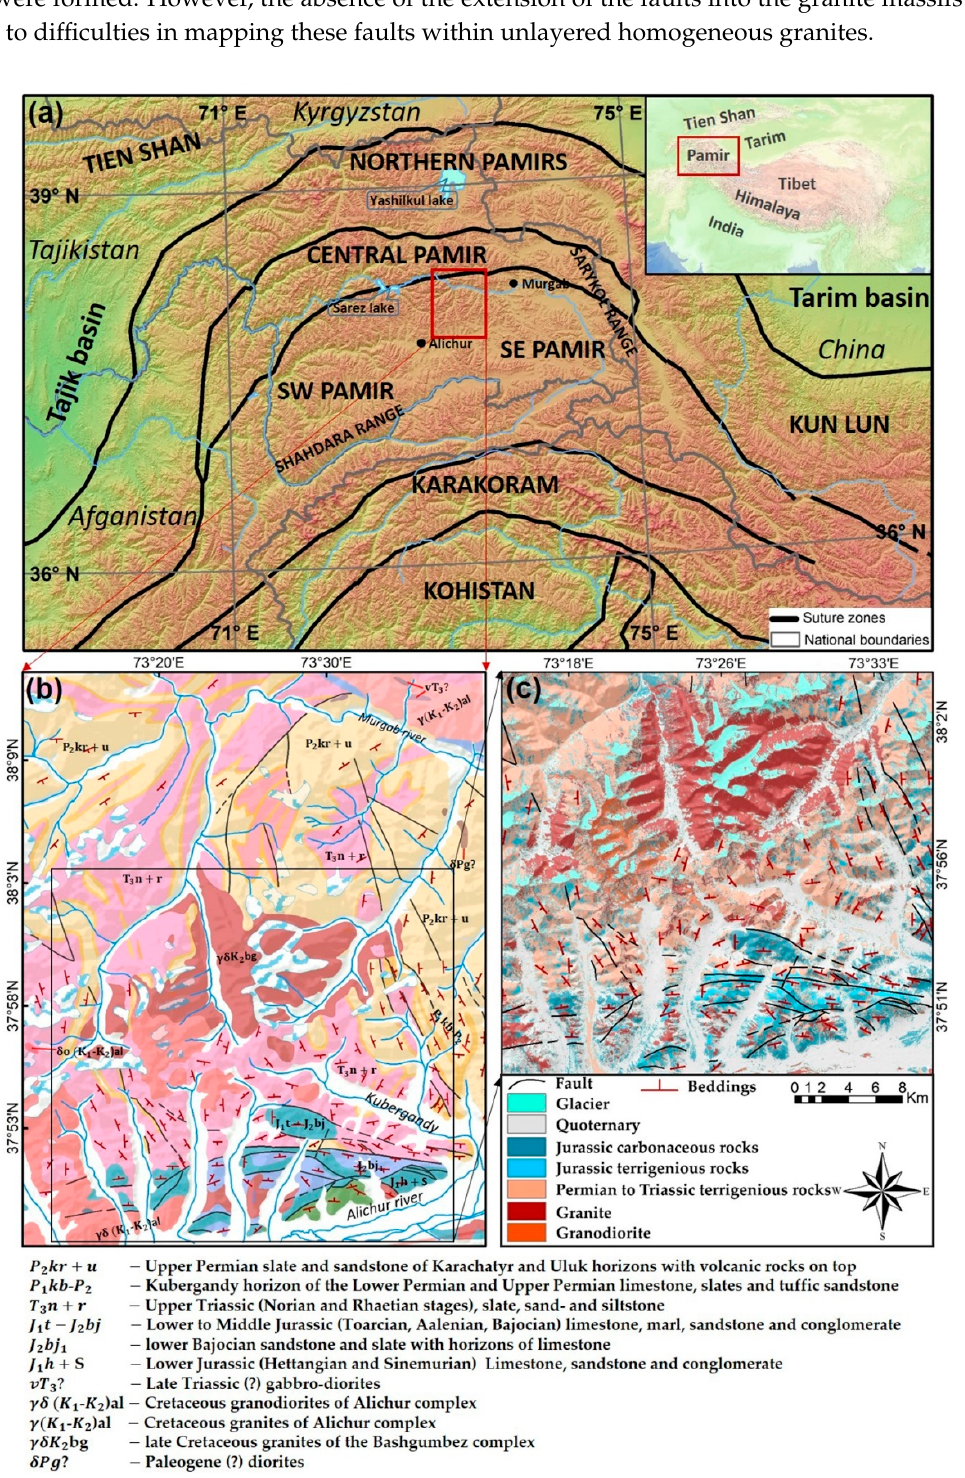
Figure 1. ( a ) A general tectonic map of the Pamir plateau; ( b ) a geological map of the study area, modified after Denikaev (1966) and Voskonyanc (1966); and ( c ) a geological map of the study area mapped with the use of remote sensing techniques [37].